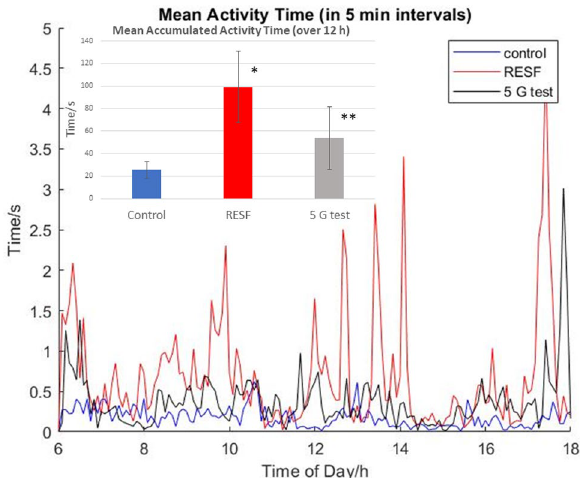
Figure 2. Mean activity time of the American cockroach (N = 29 for controls and RESF, N = 16 for 5 G test). The main plot shows the time a cockroach spends in motion (translating or rotating), averaged over all measured cockroaches. The curves are obtained by connecting points showing the mean activity time in the preceding 5 min time interval. The inset shows the mean accumulated activity time, i.e. the sum of the mean activity times over 12 h interval of the experiment. In the control runs the geomagnetic field is not modified, RESF stands for test runs with rotated Earth-strength field and 5 G test denotes experimental runs